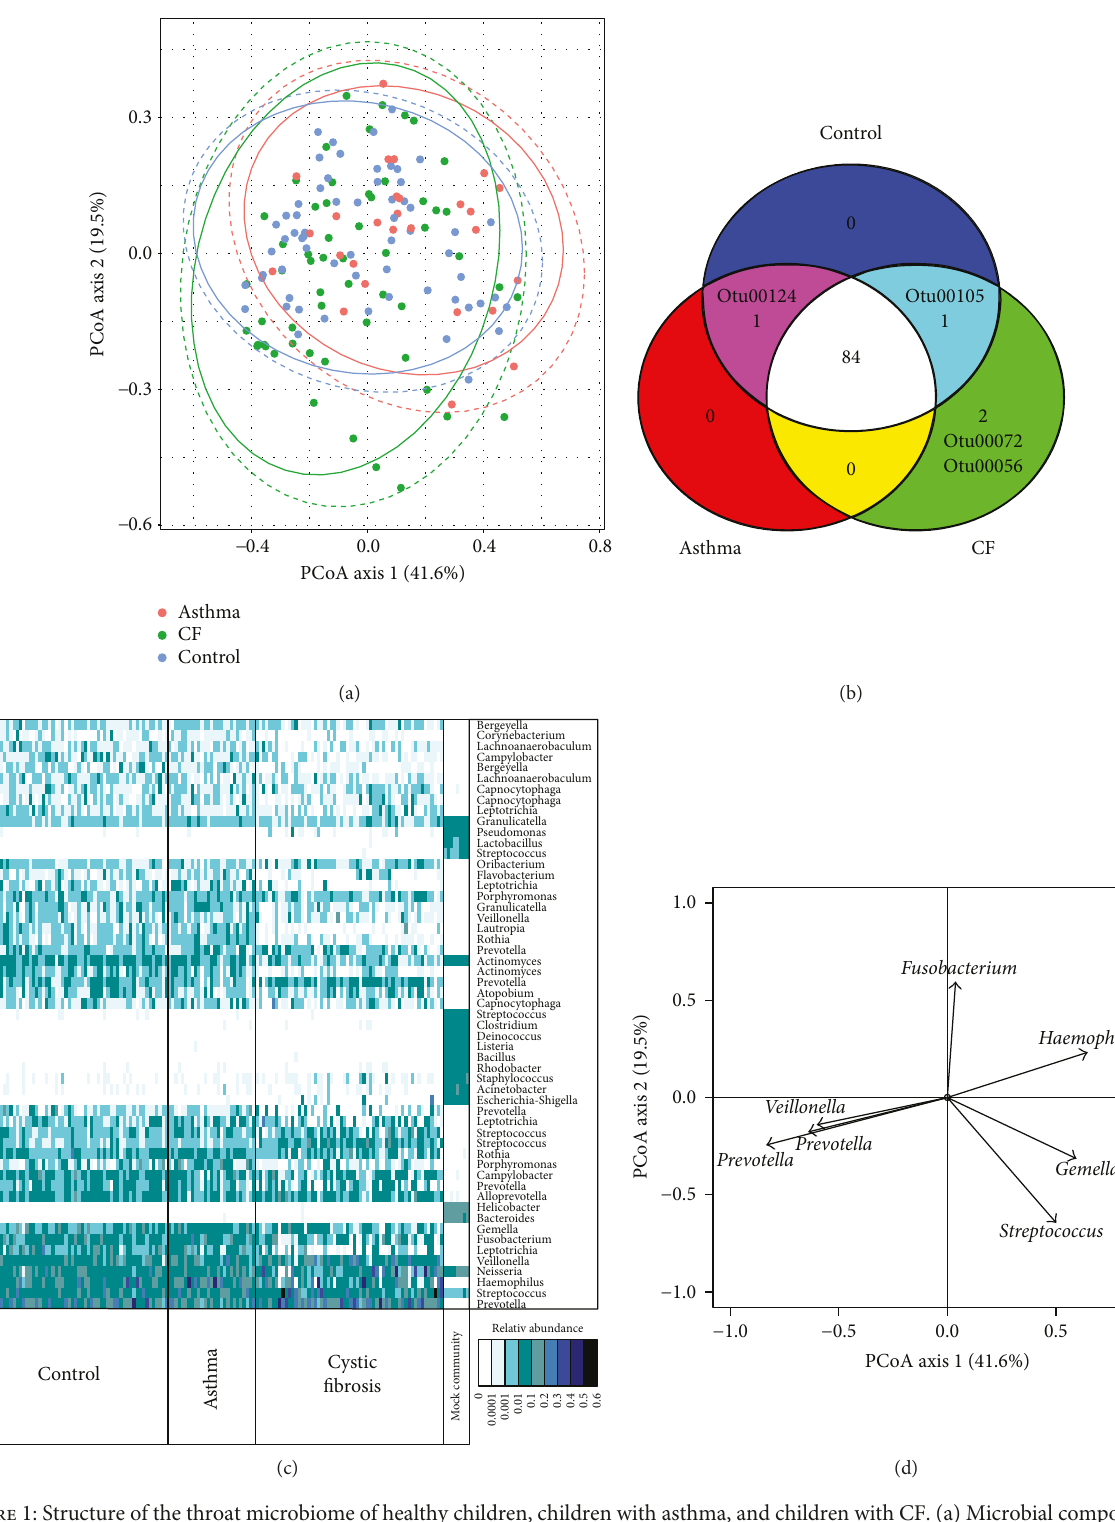
Figure 1: Structure of the throat microbiome of healthy children, children with asthma, and children with CF. (a) Microbial compositions of the whole microbiota were visualized by PCoA. The lines represent the 95% con fi dence interval assuming a multivariate t -distribution (full lines) or a multivariate normal distribution (dashed lines). (b) The presence/absence of the 88 most abundant bacteria ( > 0.1% relative abundance) was compared between the three groups and is displayed as a Venn diagram. (c) Relative abundance of the 55 most abundant OTUs in each sample clustered according to the cohorts. The mock community was an assembly of DNA from 20 known species with equimolar ribosomal RNA operon counts (100,000 copies per organism per μ L). (d) Correlation plots of the major OTUs with the two fi rst axes of the